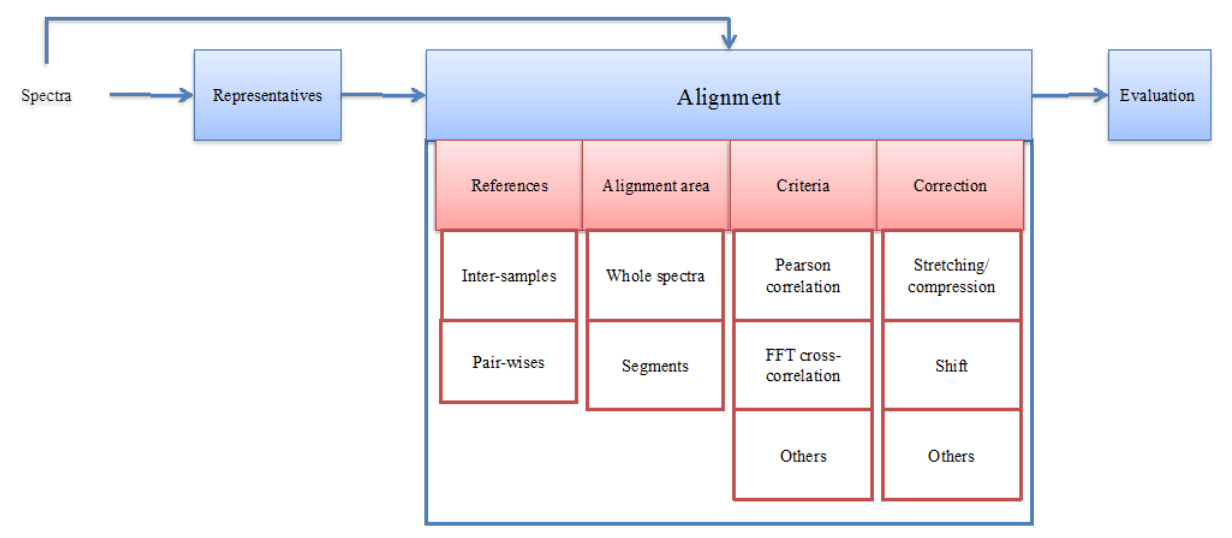
Figure 3. A general framework of Nuclear Magnetic Resonance (NMR) spectrum alignment methods. The stacked blocks with white background represent possible methodological